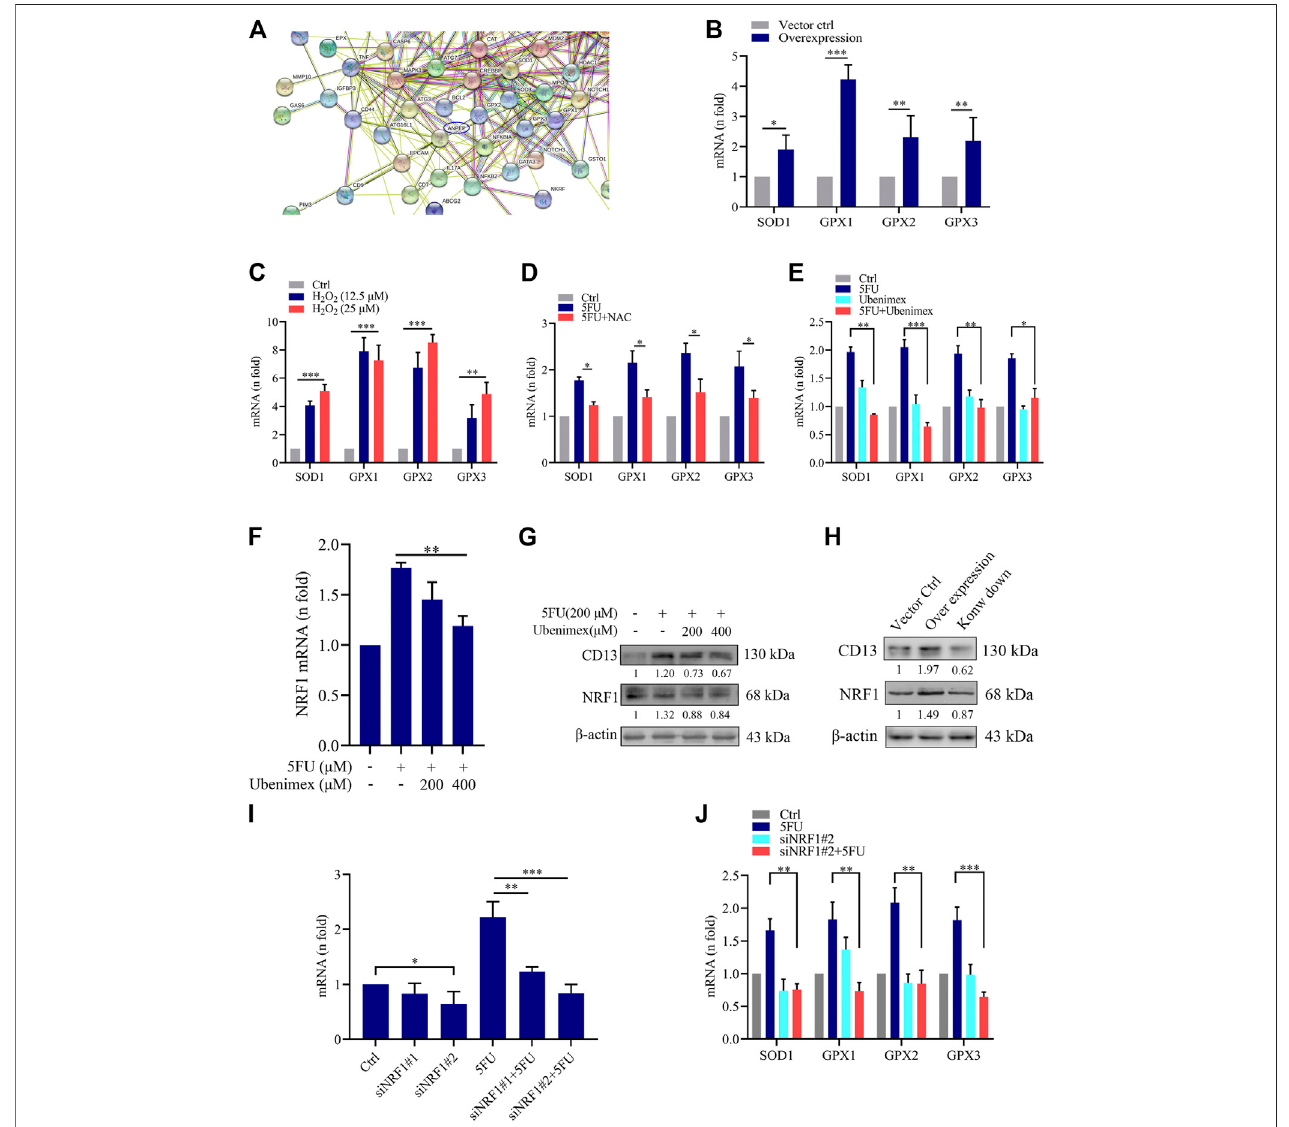
FIGURE 3 | CD13 Overexpression promotes ROS scavenging genes transcription. (A) RNA transcriptome chip analysis on the mRNA levels of vector control and CD13 overexpression PLC/PRF/5 cells. ANPEP indicates CD13. (B) The mRNA levels of SOD1, GPX1, GPX2 and GPX3 analyzed in vector control and PLC/PRF/5/ CD13 cells by qRT-RCR. (C – F) qRT-PCR on mRNA levels of ROS scavenging genes in PLC/PRF/5 cells (C) treated with H 2 O 2 (12.5, 25 μ M) for 24 h (D,E) treated with 5FU (200 μ M) combined with NAC (500 μ M) orubenimex(200 μ M) (F) treated with combination of5FU and ubenimex. Data arepresentedas mean ± SEM ( n (cid:2) 3). * p ≤ 0.05,*** p ≤ 0.001. (G) CD13andNRF1expression wasdetermined byusingImmunoblot.Arepresentativeimmunoblotfromthreeindependentexperimentsgiving similarresults isshown and β -actinwasused asaproteinloadingcontrol. (H) PLC/PRF/5 cellswereinfected withlentivirus. Afterpuromycinscreening, PLC/PRF/5 cells exhibiting stable CD13 overexpression or knockdown were obtained. Immunoblot was performed to detect CD13 and NRF1 expression. A representative immunoblot from three independent experiments giving similar results isshown and β -actin was used as aprotein loading control. (I,J) qRT-PCR on mRNA expression of NRF1